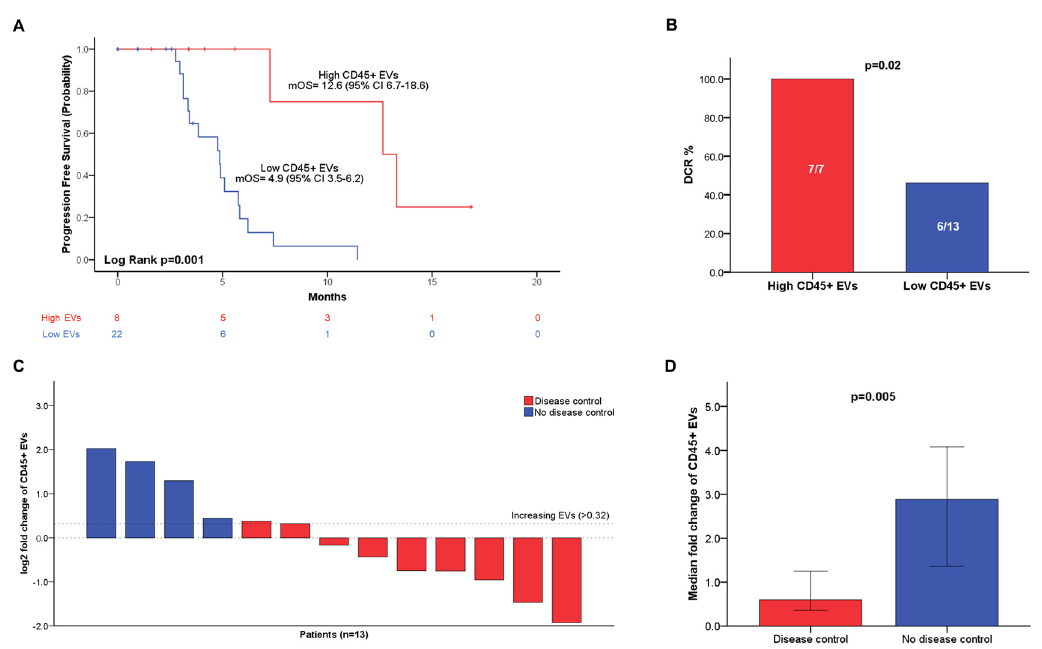
Figure 3. Kaplan–Meier (KM) curves illustrating the association between progression-free survival and blood concentration at baseline of leukocyte-derived EVs (CD45+) in the cohort of patients with locally advanced or metastatic PC ( A ); Histograms showing disease control rate in patients with high (red column) and low (blue column) CD45+ EVs ( B ); Waterfall plot depicting distributions of patients with disease control (red column) or progressive disease (blue column) after standard chemotherapy according to variations in blood concentrations of leukocyte-derived EVs (CD45+) during treatment ( C ); Bar charts with error bars showing difference in median fold change in leukocyte-derived EVs (CD45+) in patients with disease control (red bar) or progressive disease (blue bar) ( D ). Error bars represent 95% confidence intervals. Log-rank test was used to statistically compare KM survival curves. DCRs were compared using Fisher’s exact test. Fold changes were compared using Mann–Whitney U test.